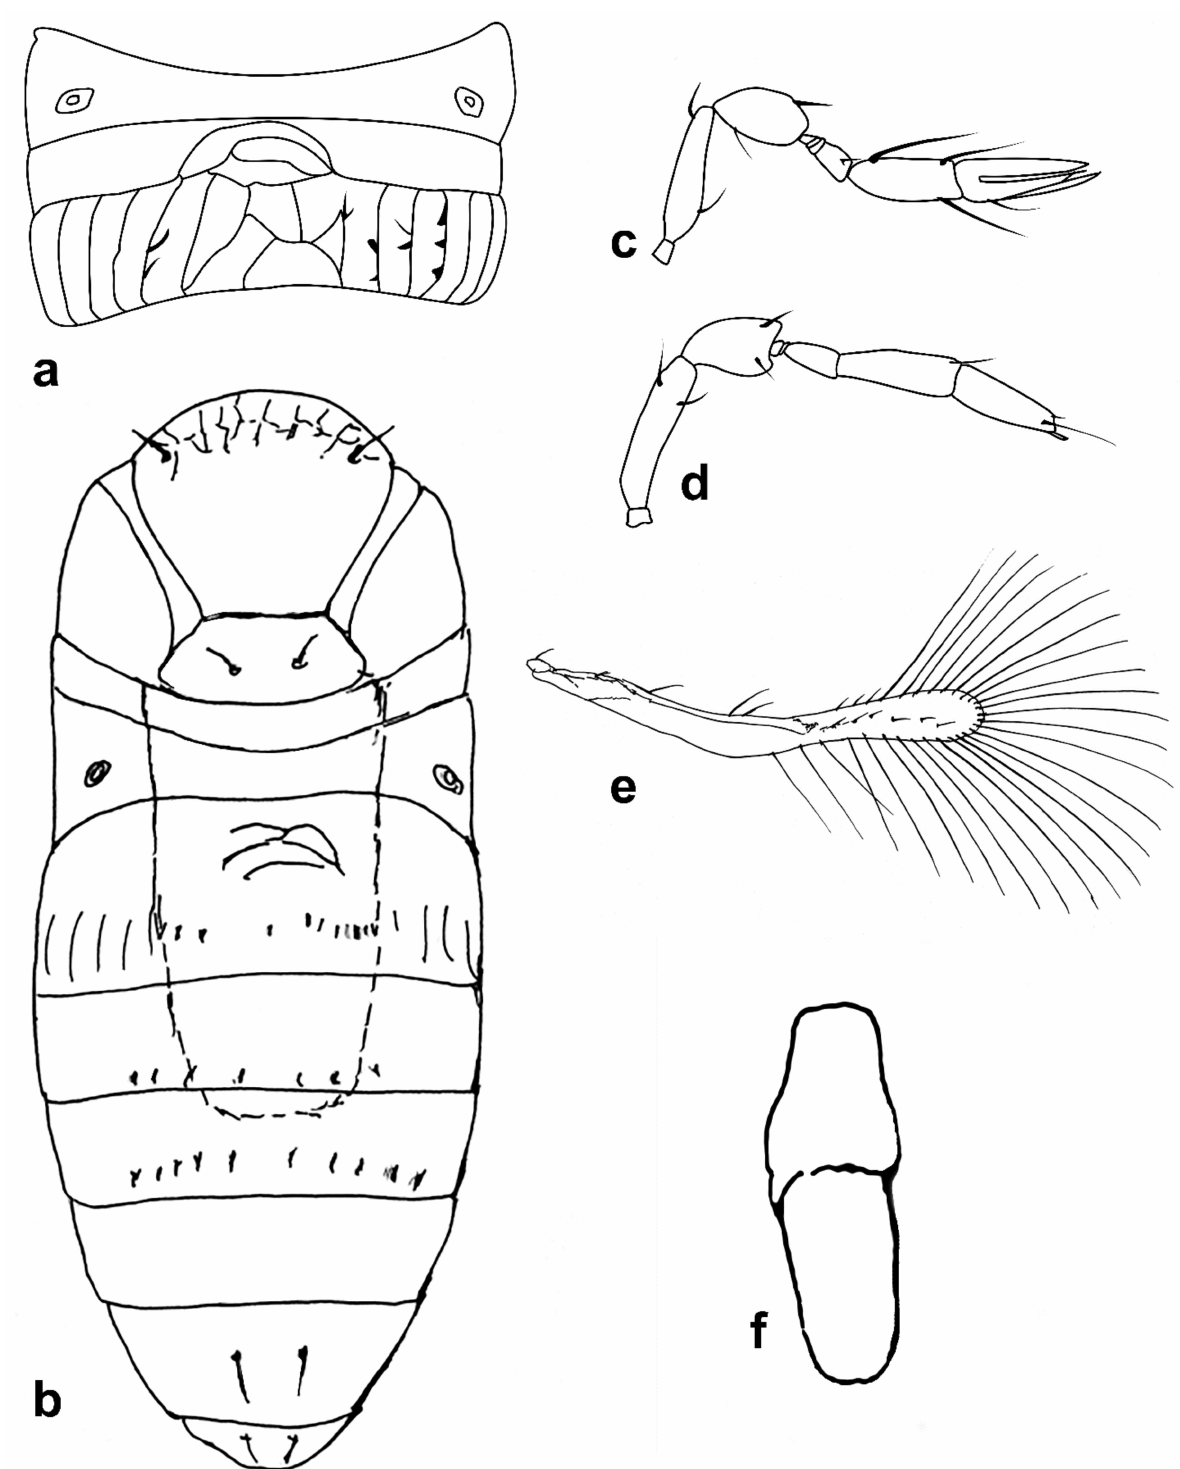
Figure 7. Line drawings of Megaphragma species: ( a ) M. nowickii , female propodeum and T1 (Holo- type); ( b ) M. nowickii , male meso- and metasoma (Paratype); ( c ) M. nowickii , female antenna (Holo- type); ( d ) M. nowickii , male antenna (Paratype); ( e ) M. nowickii , female fore wing (Holotype); ( f ) M. nowickii , male aedeagus